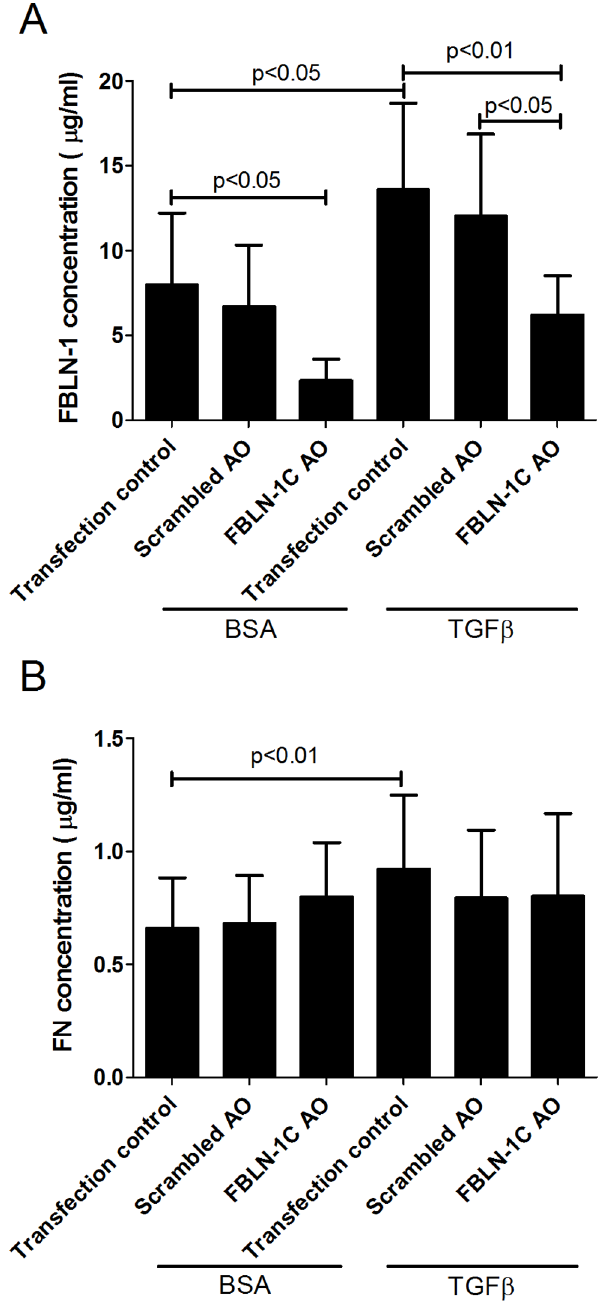
Figure 7. FBLN-1C AO does not alter FN deposition in ECM. Inhibition of ECM deposited FBLN-1 (A) or FN (B) following transfection with a FBLN-1C AO or a scrambled AO in ASM cells from asthmatic volunteers (n=4) basally or following treatment with TGF b for 24 h. Data are expressed as mean 6 SEM. Concentrations were obtained by interpolation of standard curves.